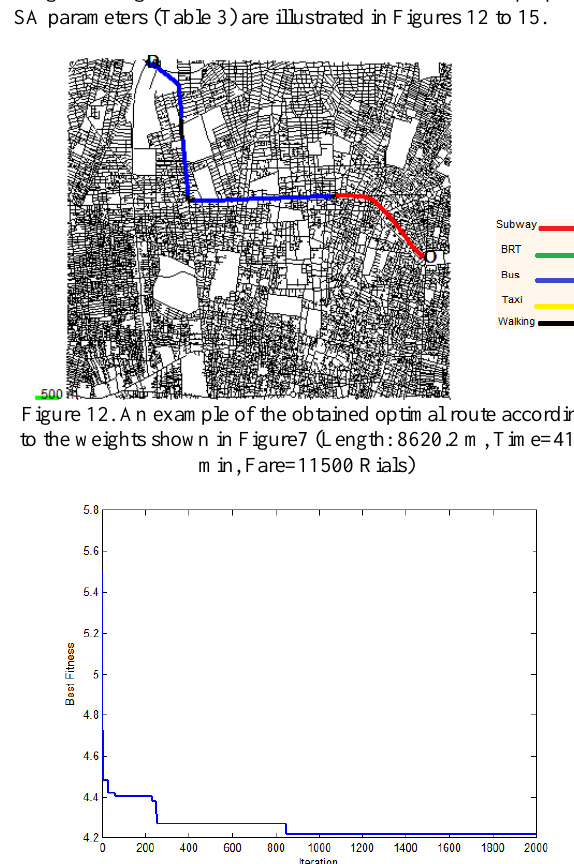
Figure 13. Convergence plot of the optimal route shown in Figure 12.